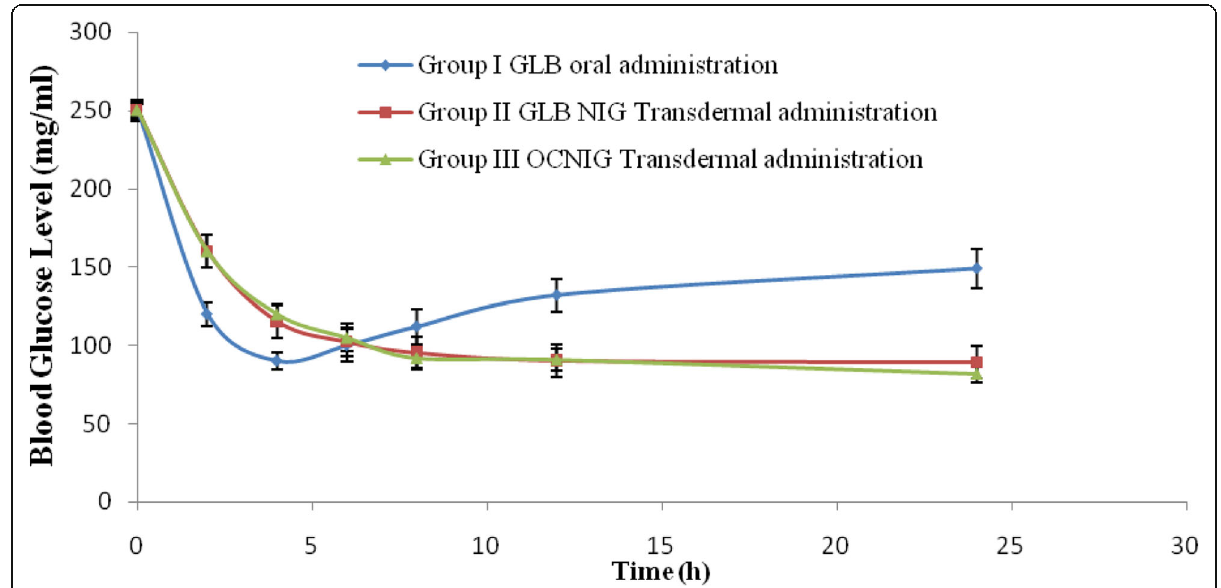
Fig. 10 Showing changes in blood glucose levels after oral administration of GLB suspension, GLB NIG, and OCNIG in streptozocin-induced